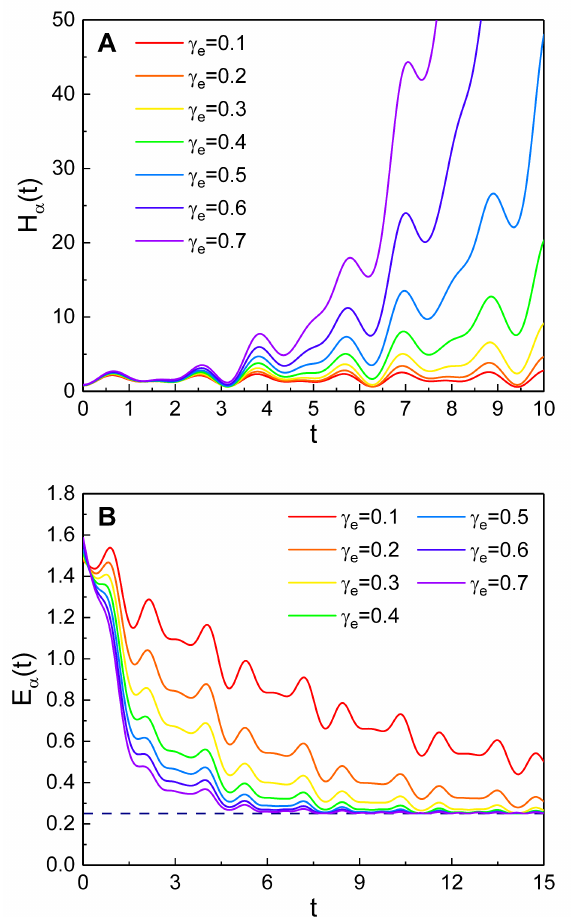
Figure 1. The dependence of time evolution of the Hamiltonian expectation value ( A ) and the quantum energy ( B ) on γ e . The values that we have used are ω e = 1, ϕ = 0, α 0 = 1, ω = 5, m = 1, ¯ h = 1, and f d = 0.5. The reference line (dashed line) in the bottom part of ( B ) is 0.25, which is the minimum value of the quantum energy in this model; this rule will also be applied in the subsequent figures of the quantum energy (Figures 2C and